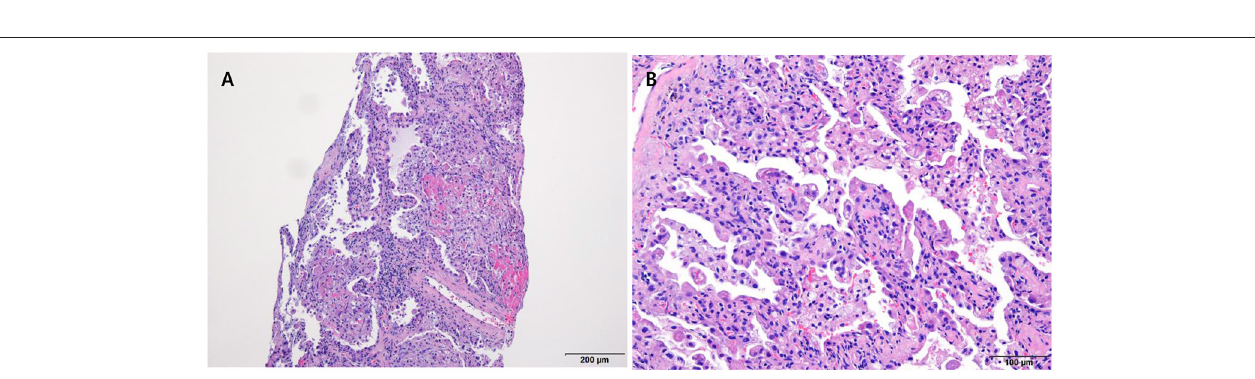
FIGURE 2 | Pathologic examination of the lung via trans-thoracic needle biopsy showing amiodarone-induced lung toxicity. (A) Chronic interstitial pneumonitis and interstitial fibrosis and focal fibrinoid necrosis. (B) Accumulation of foamy macrophages within alveolar spaces.